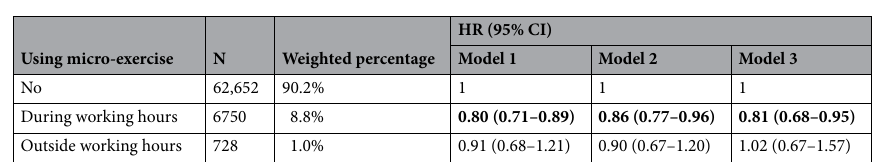
Table 2. Hazard ratios and 95% confidence intervals for the risk of long-term sickness absence during follow-up from use of micro-exercise during and outside of working hours. Significant findings are marked in bold. Model 1: Controlled for age, sex, education, survey year. Model 2: Controlled for age, sex, education, survey year, lifestyle (BMI, smoking, leisure physical activity), psychosocial work factors (work-life balance and influence at work), depressive symptoms (MDI), and pain frequency. Model 3: Sensitivity analysis of model 2, including only healthy individuals at baseline (normal MDI score, monthly or less frequent pain)(n = 45,570).